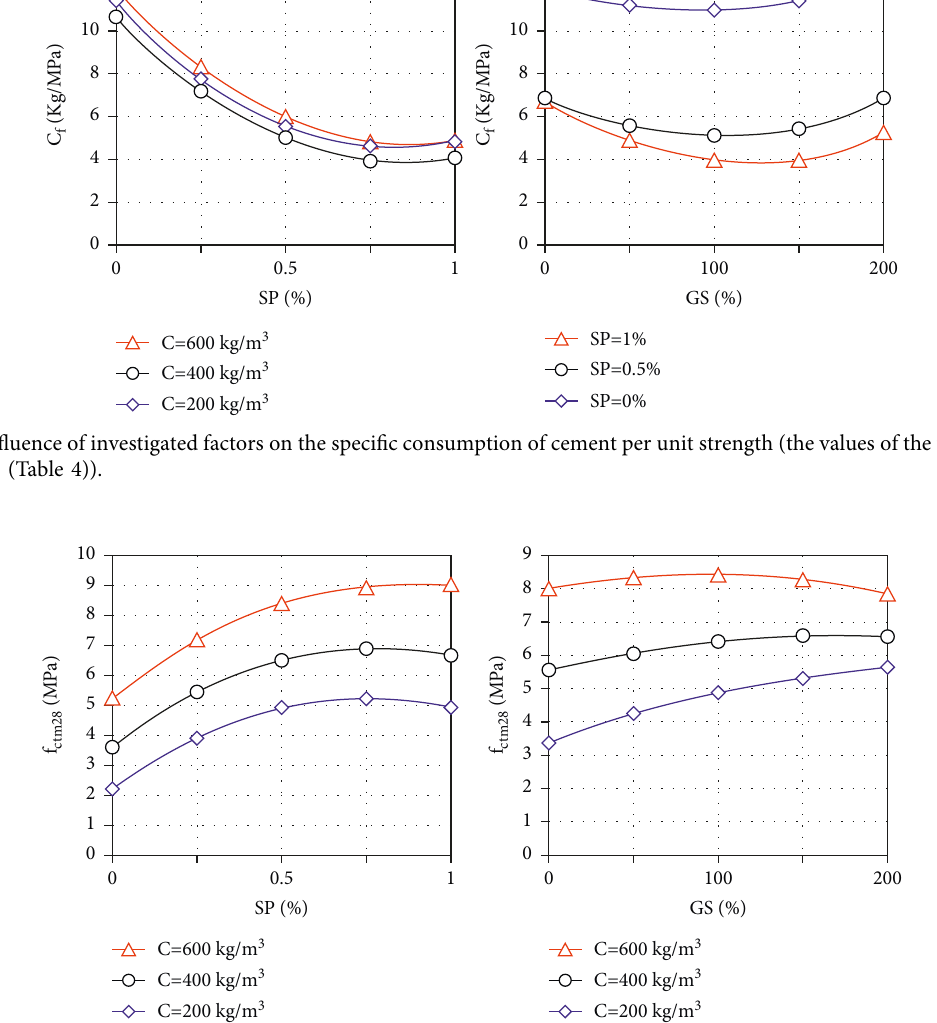
Figure 8: Influence of SP and blast furnace slag contents at different cement consumption levels on SCC splitting tensile strength at 28days (the values of the third factor are at the average level (Table 4)). Table 7: Correlation dependences of SCC strength on C/W. Parameter Equation